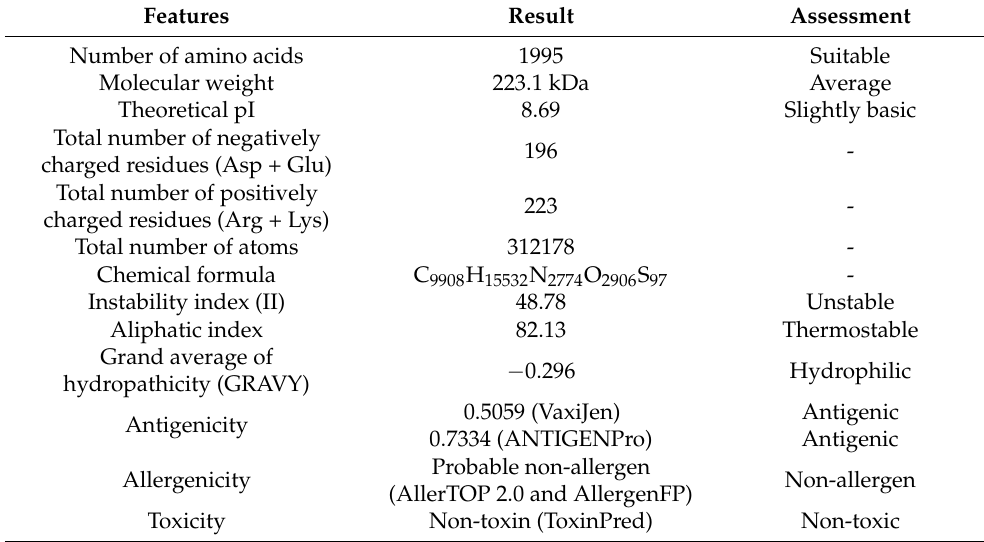
Table 4. Allergenic, antigenic, physicochemical assessments, and toxicity of the vaccine construct.